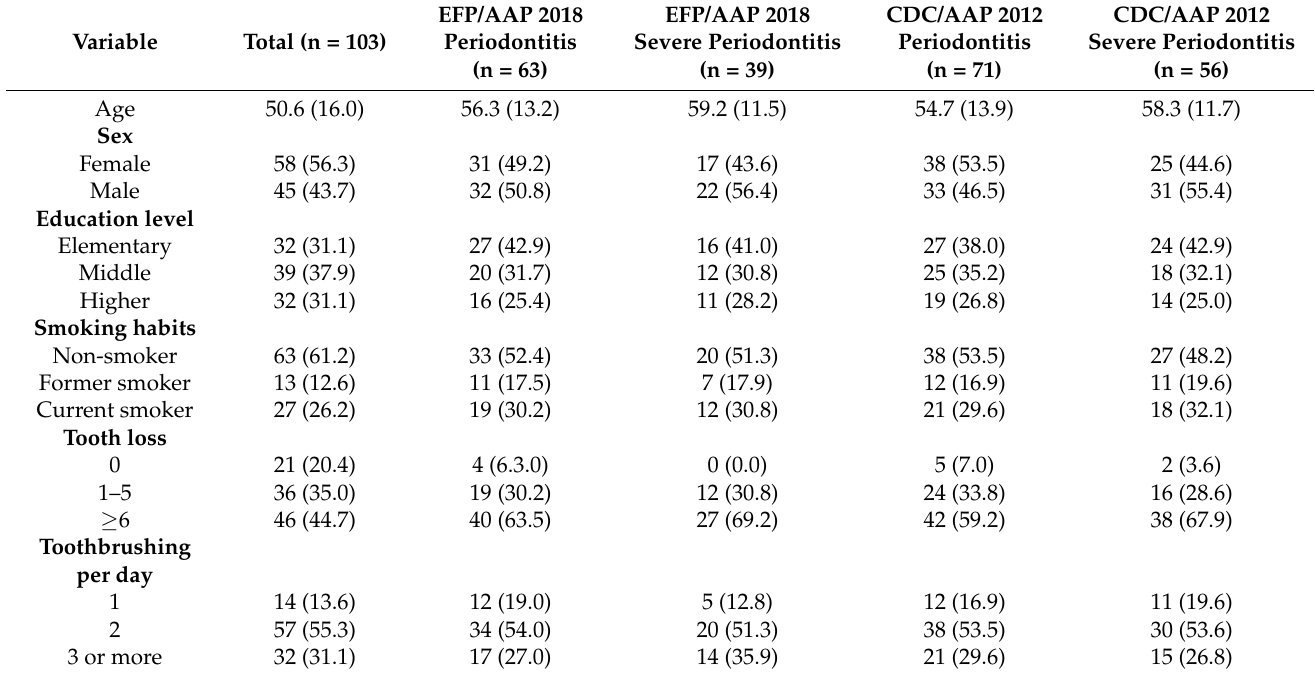
Table 2. Socio-demographic characteristics of the